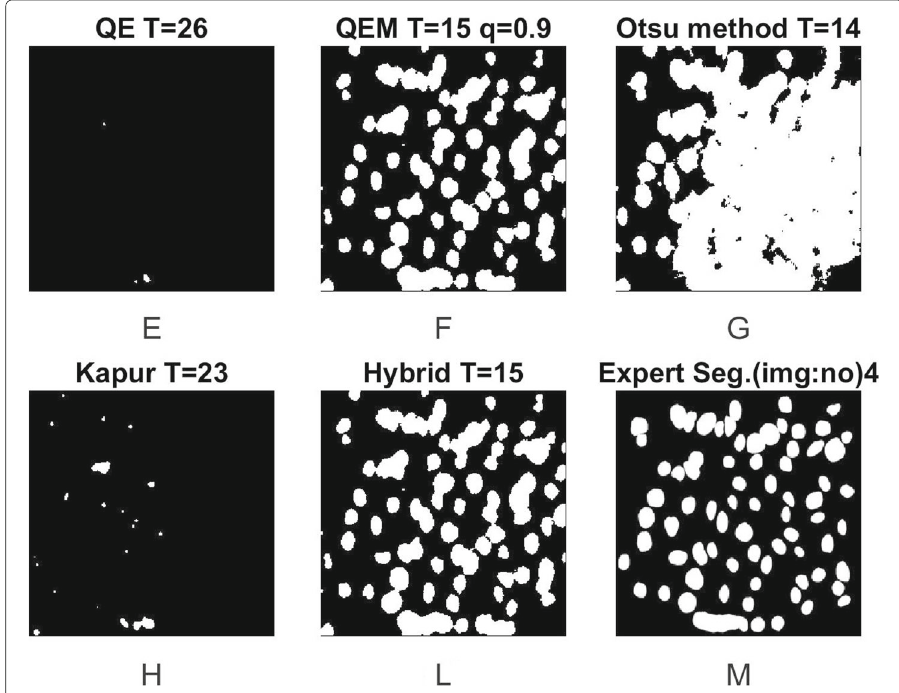
Fig. 4 F-measure = [0.0067 0.8039 0.5159 0.0695 0.8039] for quantum entropy, modified quantum entropy (proposed), Otsu, Kapur, and hybrid of the proposed with the Otsu methods,